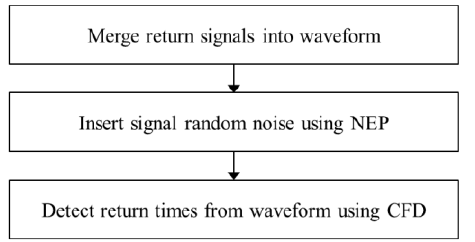
Figure 9. Processes of waveform